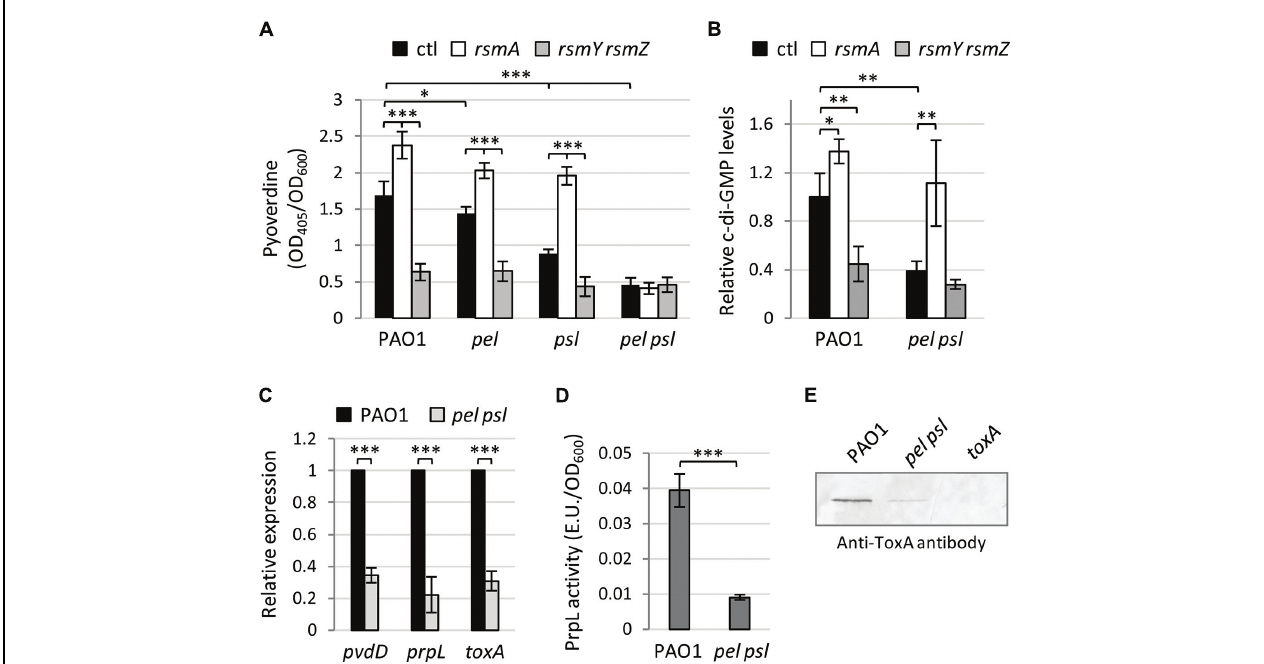
FIGURE 1 | The exopolysaccharides Pel and Psl are essential for Gac-mediated control on pyoverdine production and positively regulate pyoverdine-dependent virulence factors. (A) Pyoverdine production by Pseudomonas aeruginosa PAO1, pel , psl , and pel psl mutants, and their derivatives deleted in the rsmA or in the rsmY and rsmZ genes. (B) Intracellular levels of c-di-GMP (relative to wild type PAO1) in P. aeruginosa PAO1, the pel psl mutant, and their derivatives deleted in the rsmA or the rsmY and rsmZ genes. (C) Relative mRNA levels of pvdD , toxA , and prpL as determined by qRT-PCR, and (D)